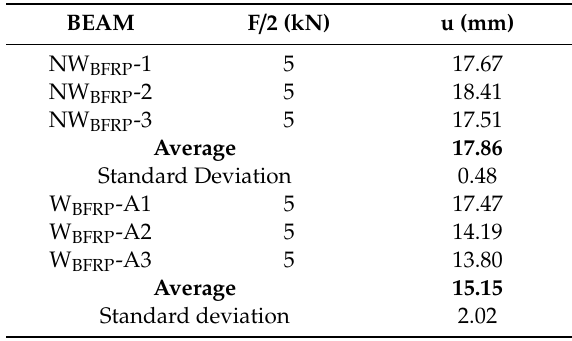
Figure 6. Graph of the “F / 2–u” relationship in beams for sensor 2—mid-span of the beam. Table 3. The results of deflections u (mm) for a series of wooden